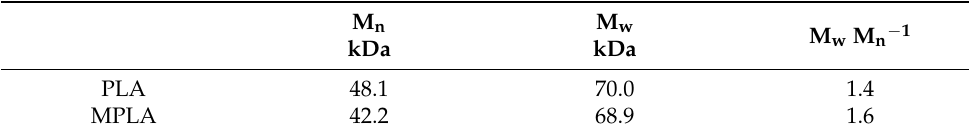
Table 1. GPC data for PLA and MPLA.